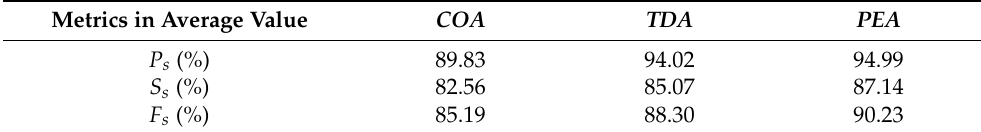
Table 2. Results comparison of LVNS-based NILM for traditional approaches.